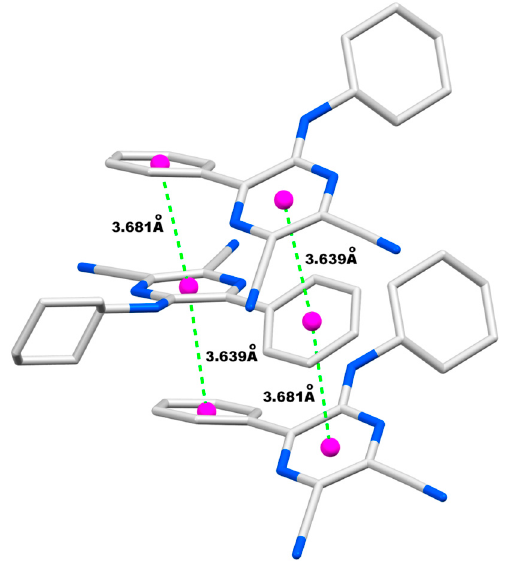
Figure 5. π – π interactions between 13a molecules in their crystal network.